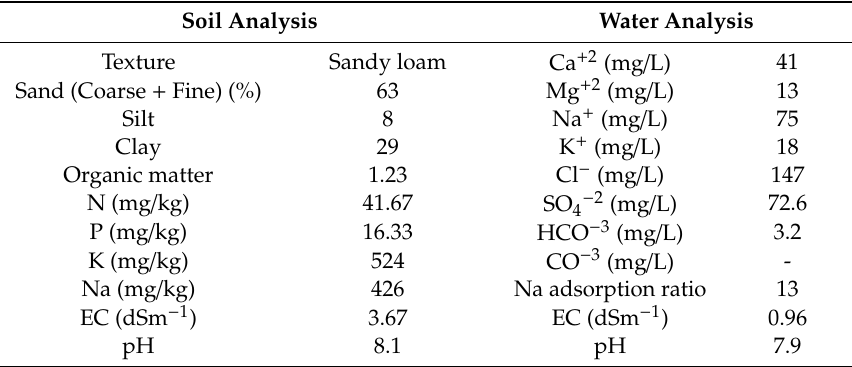
Table 1. Soil and water